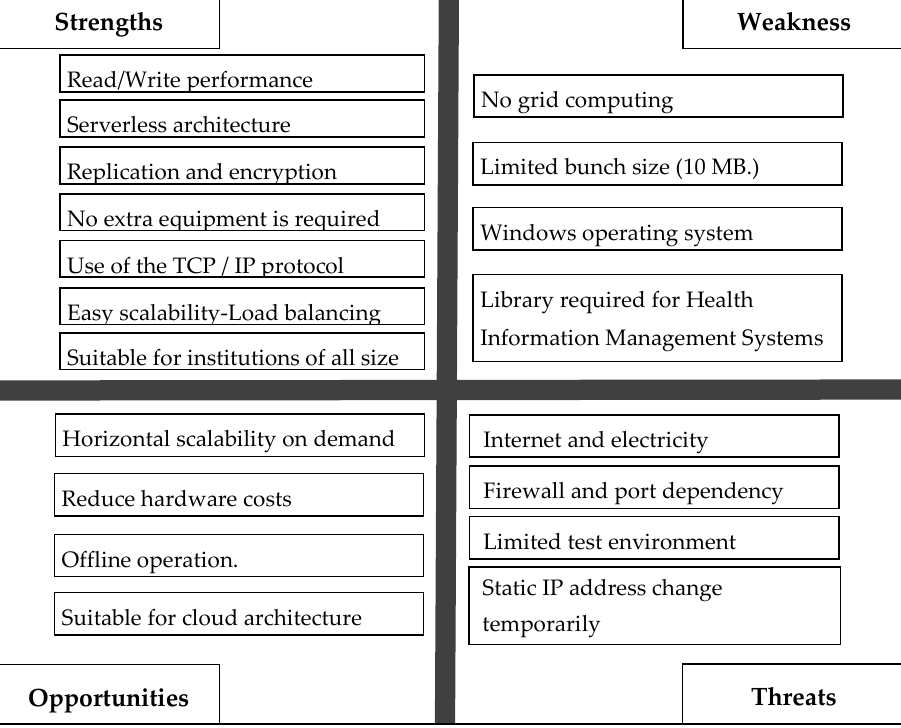
Figure 9. SWOT Analysis of the proposed system.